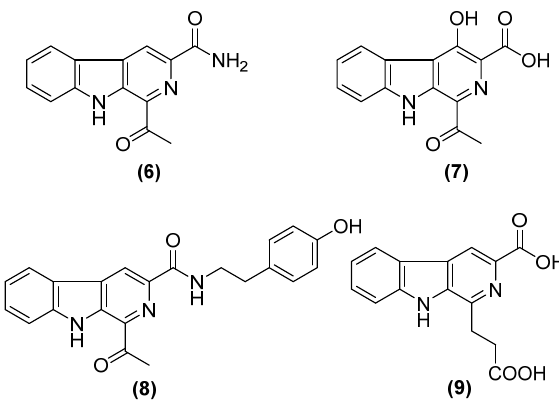
Figure 3. Chemical structures of selected known compounds related to this study. Table 2. Antimicrobial and cytotoxicity activities of 1 - 5.